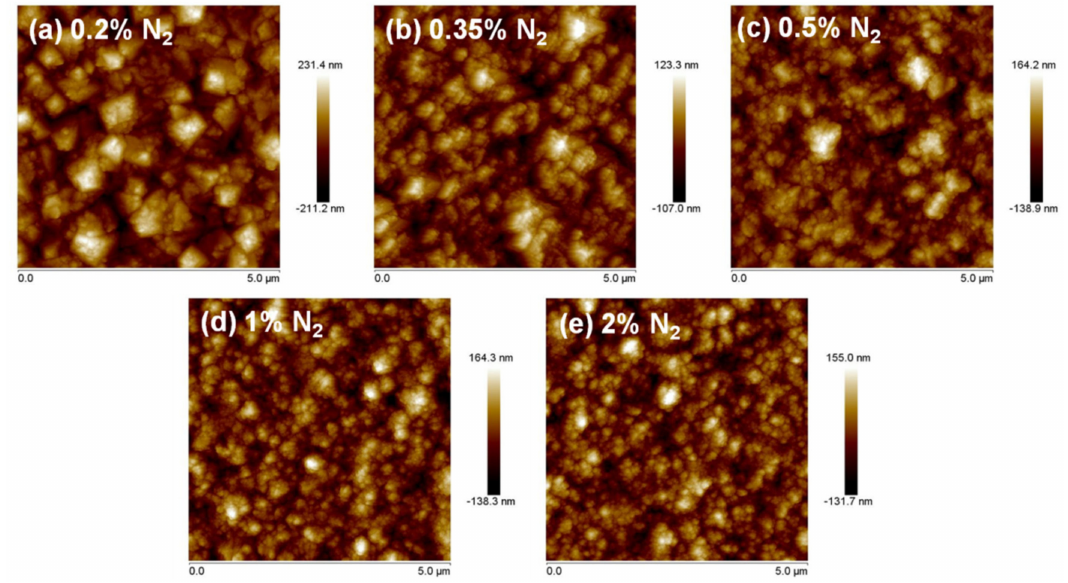
Figure 2. Topographic AFM images of the samples grown with ( a ) 0.2% N 2 , ( b ) 0.35% N 2 , ( c ) 0.5% N 2 , ( d ) 1% N 2 and ( e ) 2% N 2